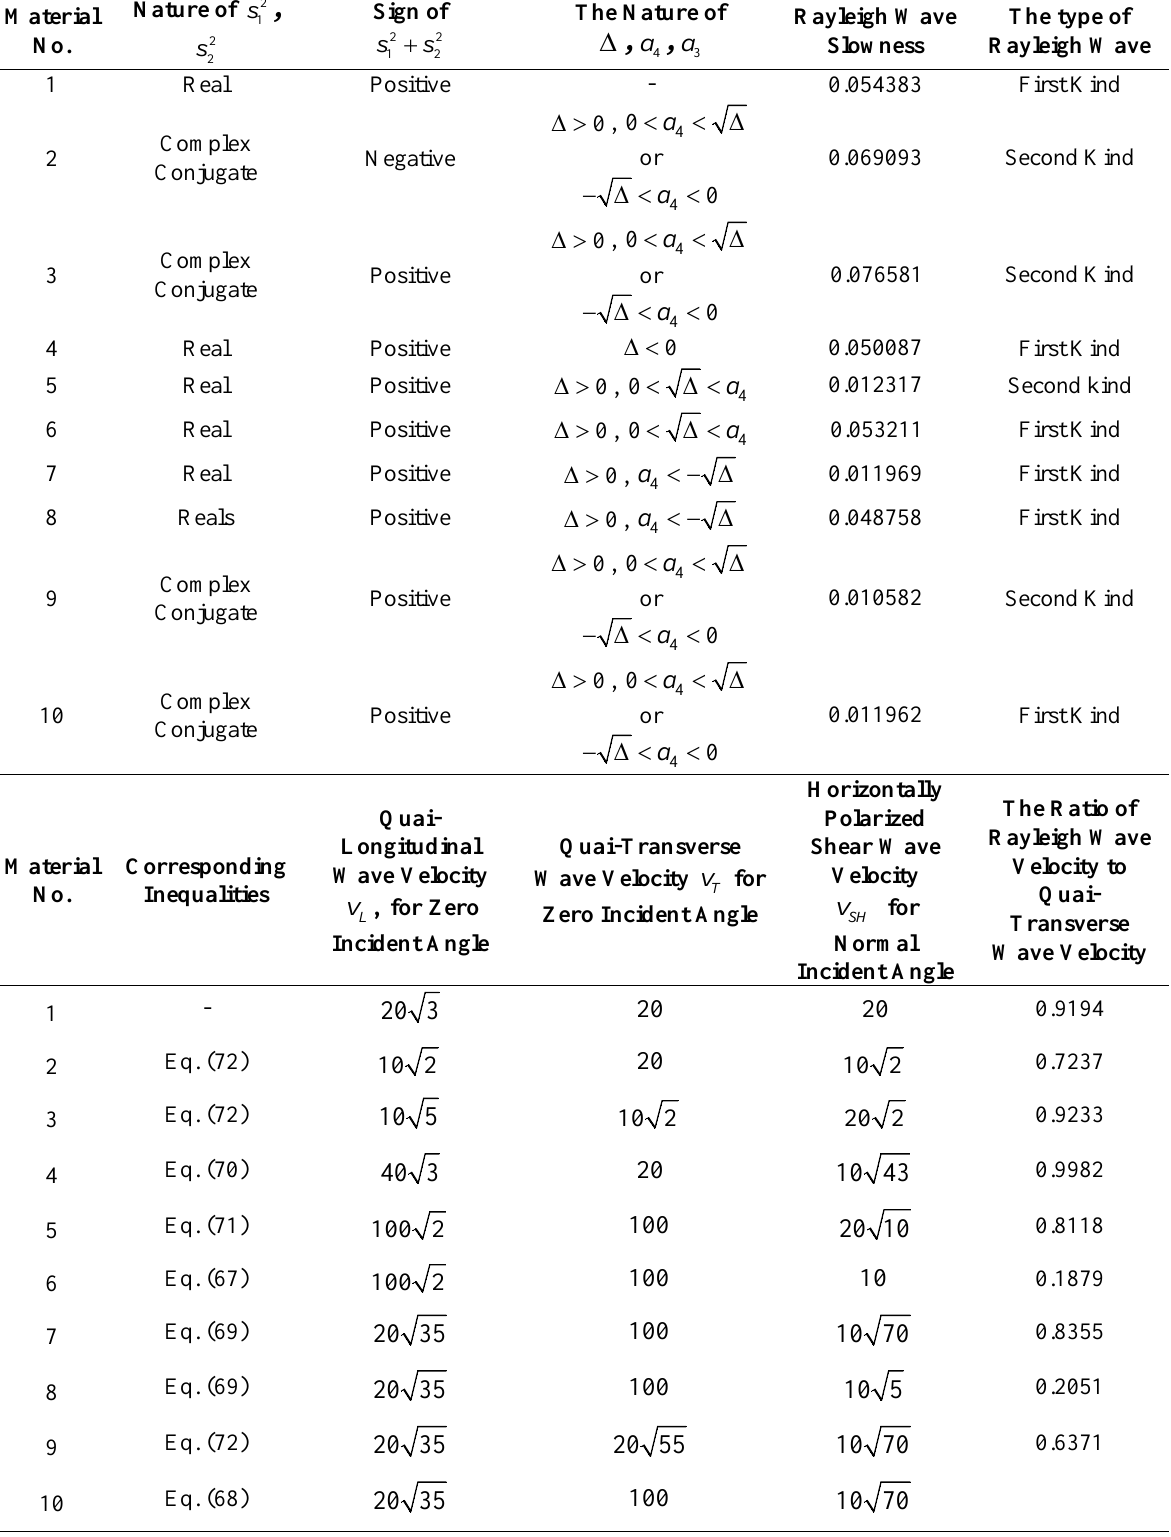
Table A3. Rayleigh wave